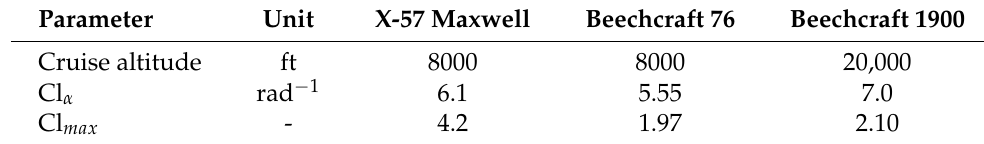
Table A3. Aircraft aerodynamics.